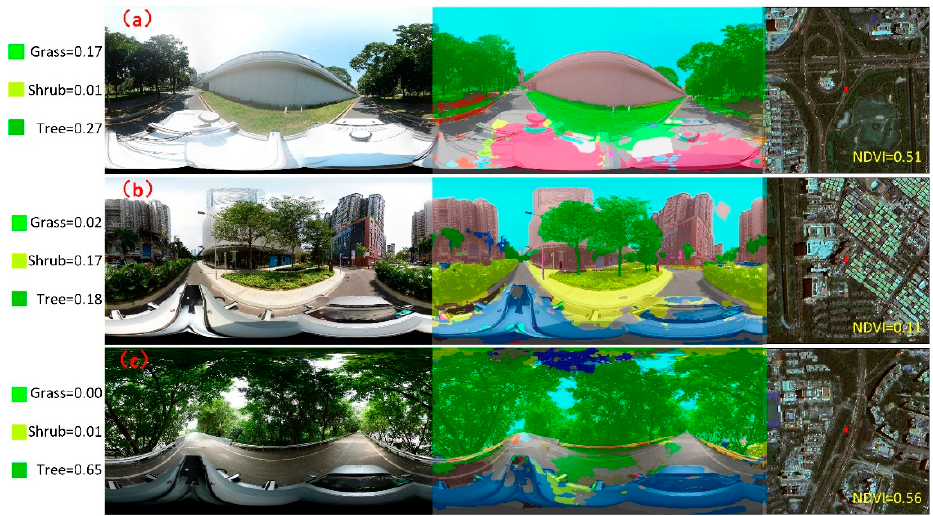
Figure 8. Comparison of street view images and remote sensing images (the locations at which the street view images were taken are labeled in the remote sensing images by red markers). ( a ) Grass dominated; ( b ) Shrub dominated; ( c ) Tree dominated.